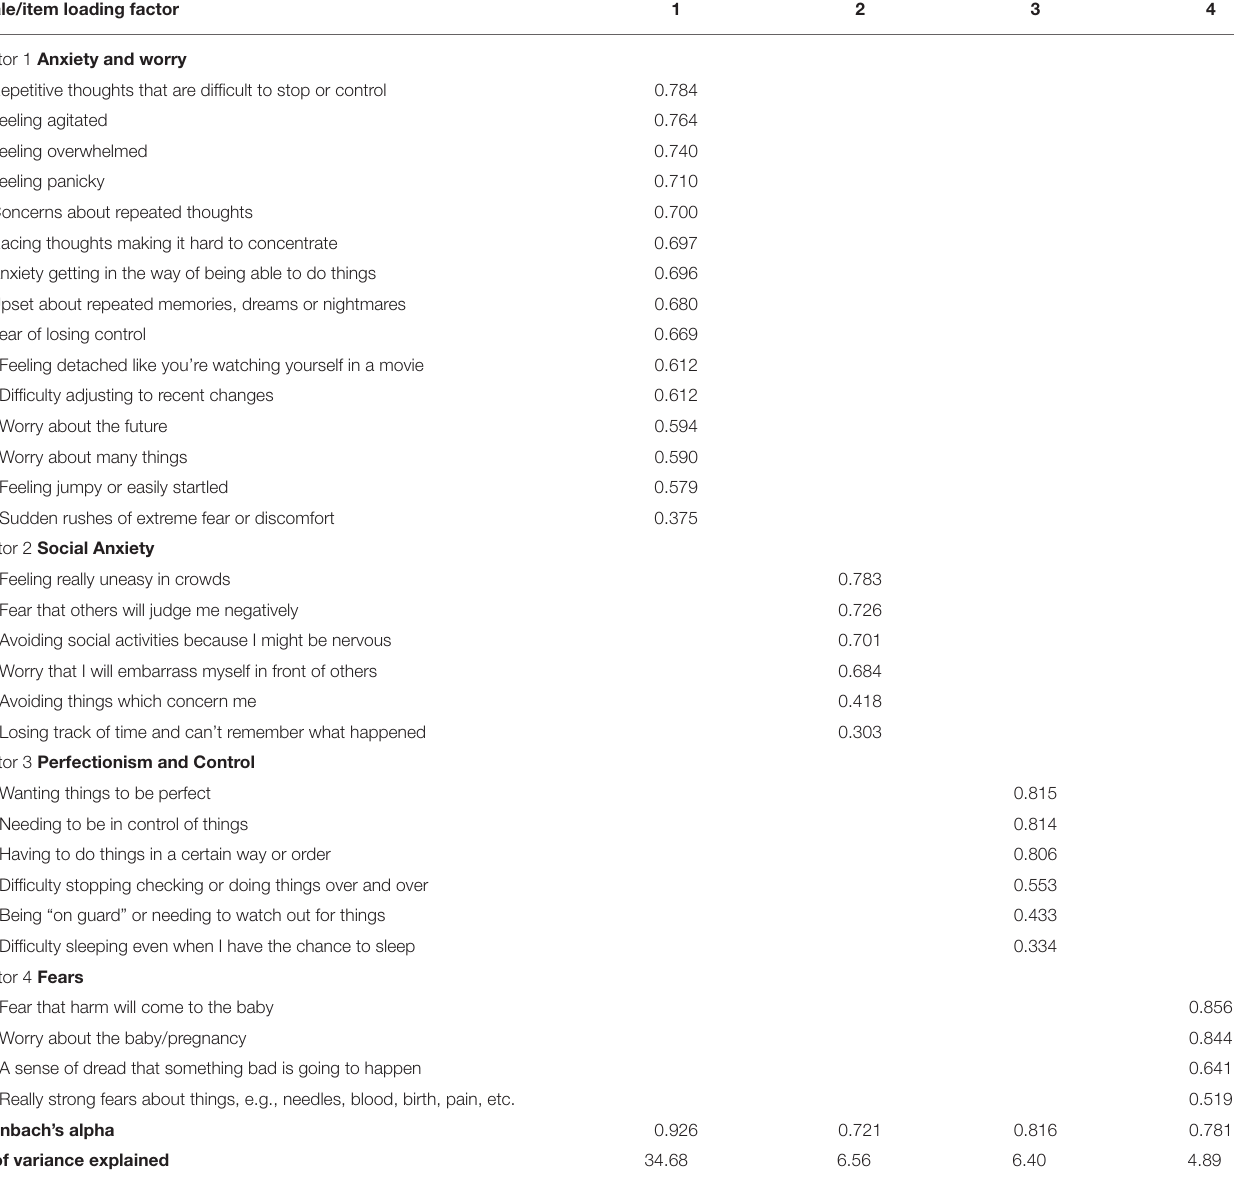
TABLE 2 | Factor structure of the Perinatal Anxiety Screening Scale (PASS). Scale/item loading factor Factor 1 Anxiety and worry